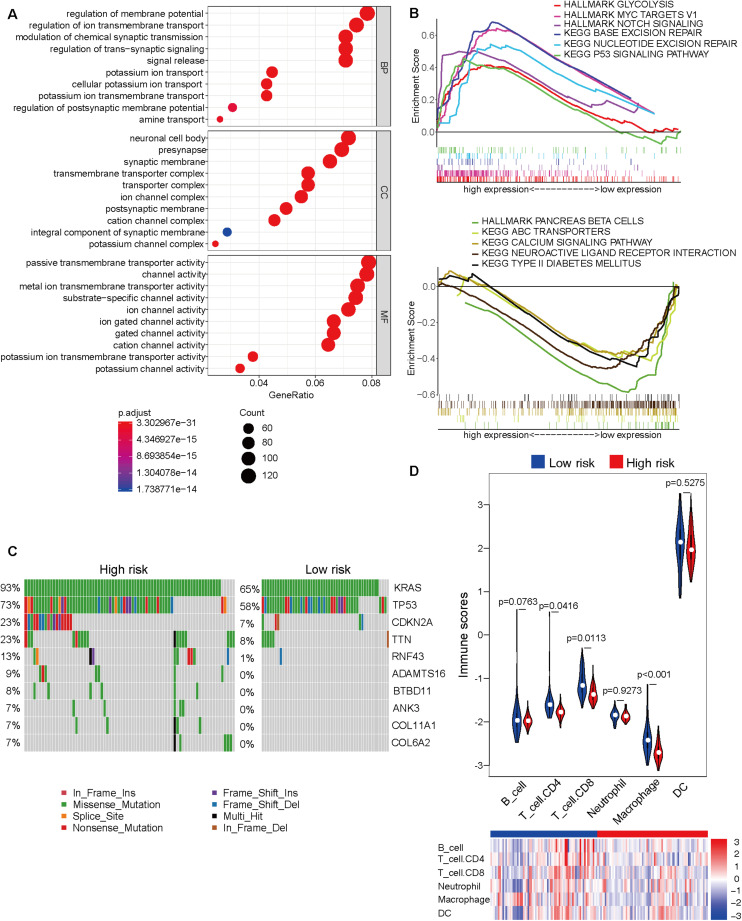
Molecular characteristic analyses of the high-risk and low-risk groups based on the prognostic prediction model. (A) The results of Gene Ontology analysis of the high-risk and low-risk groups, including biological process (BP), cellular component (CC), and molecular function (MF). (B) The activated (top) and inhibited (bottom) signaling pathways in the high-risk and low-risk groups were subjected to Gene Set Enrichment Analysis (GSEA). (C) The comparative mutation spectrum analysis of the top 10 genes in the high-risk and low-risk groups. (D) The immune infiltration analysis of six immune cell types in the high-risk and low-risk groups based on the Tumor Immune Estimation Resource (TIMER) website.